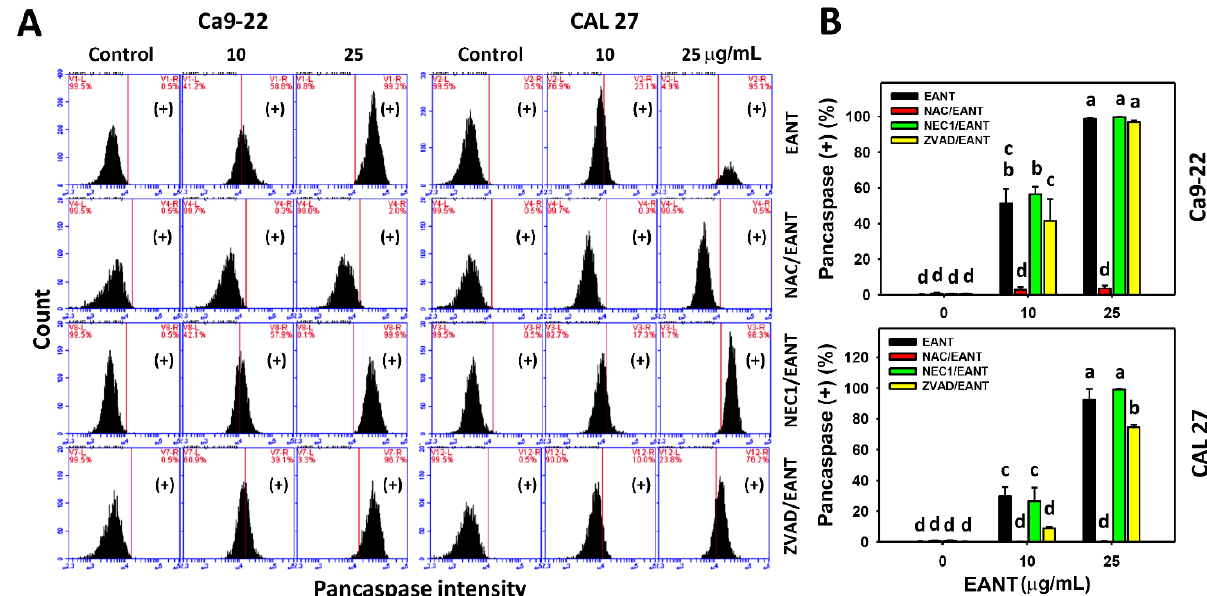
Figure 4. Pancaspase activation analysis. ( A , B ) Pancaspase flow cytometry and statistics. With the inhibitor pretreatments for oxidative stress, necrosis, and apoptosis (10 mM NAC for 1 h, 50 μM NEC1 for 1 h, and 100 μM ZVAD for 2 h), or not, oral cancer cells (Ca9-22 and CAL 27) were treated with EANT (control, 10, 25 μg/mL) for 24 h. Data (mean ± SD, n = 3) showing different letters on-top differ significantly for multiple comparisons ( p < 0.05).